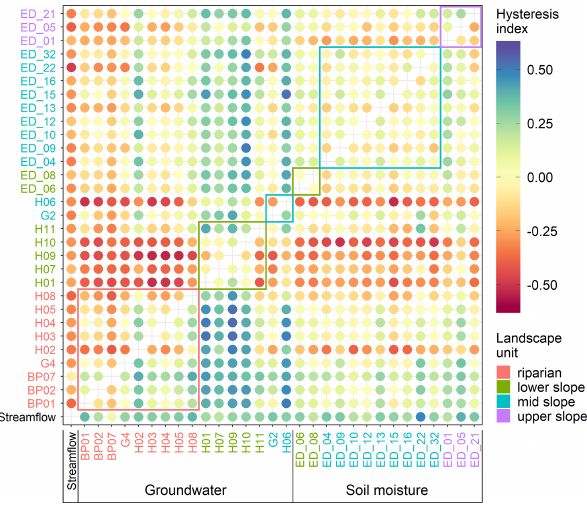
Figure 7. Median hysteresis index between streamflow at catch- ment outlet (streamflow), groundwater (BP ∗∗ , H ∗∗ , G ∗ ) and soil moisture (ED_ ∗∗ ) for all events. Hysteresis index is positive if the row station peaks before the column station and negative if the row station peaks after the column station. Circles’ colour corresponds to the value of the hysteresis index. The station names’ colour cor- responds to their landscape unit. Coloured rectangles enclose values of stations in the same landscape unit.